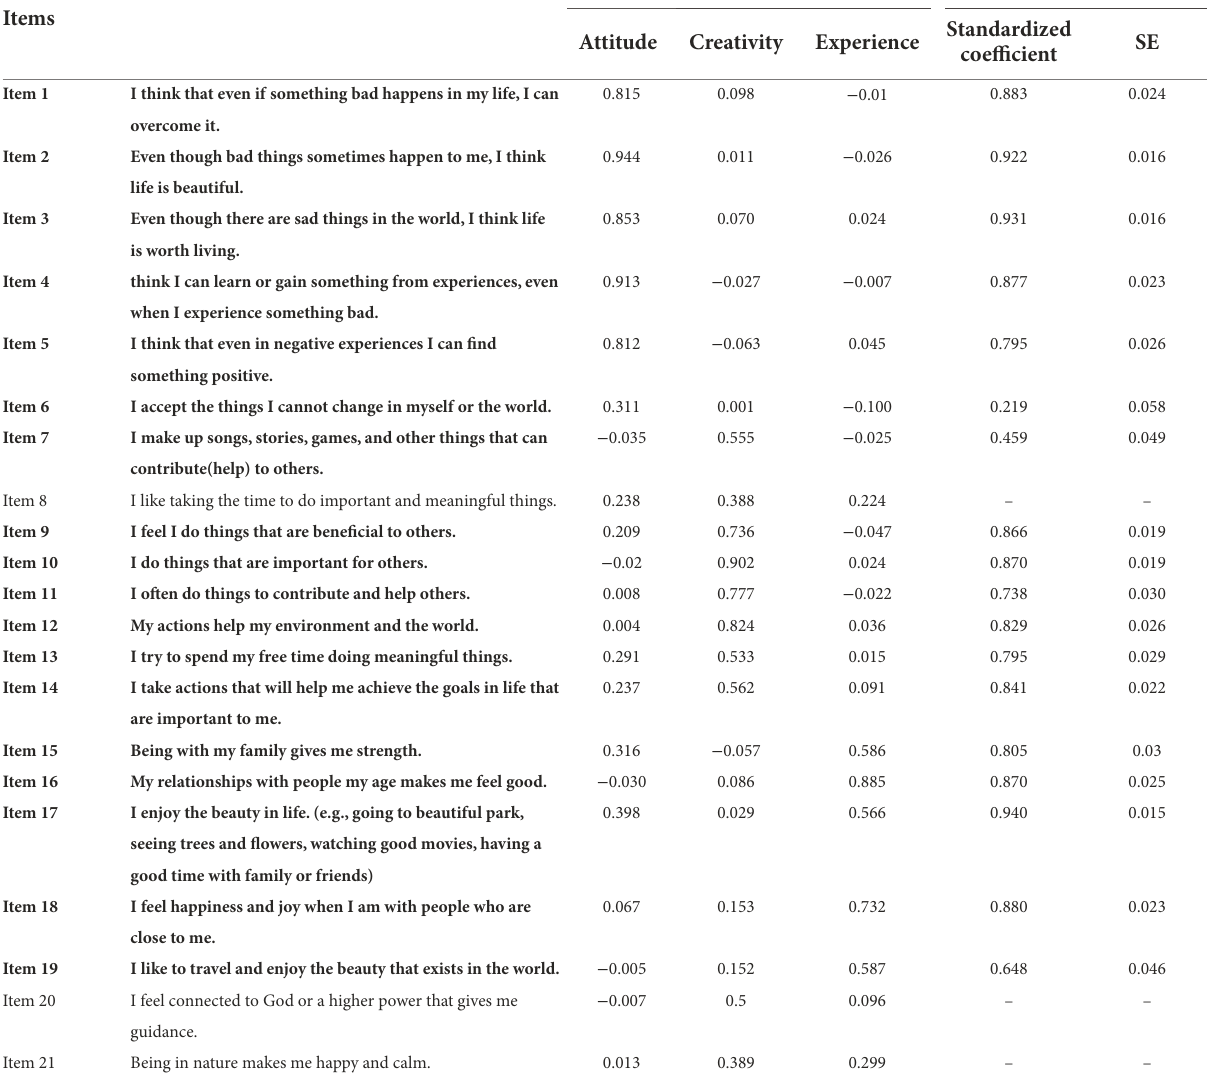
TABLE 3 Items of K-MIL-CQ, factor loadings of EFA and standardized coefficients of second-order factor model. Items